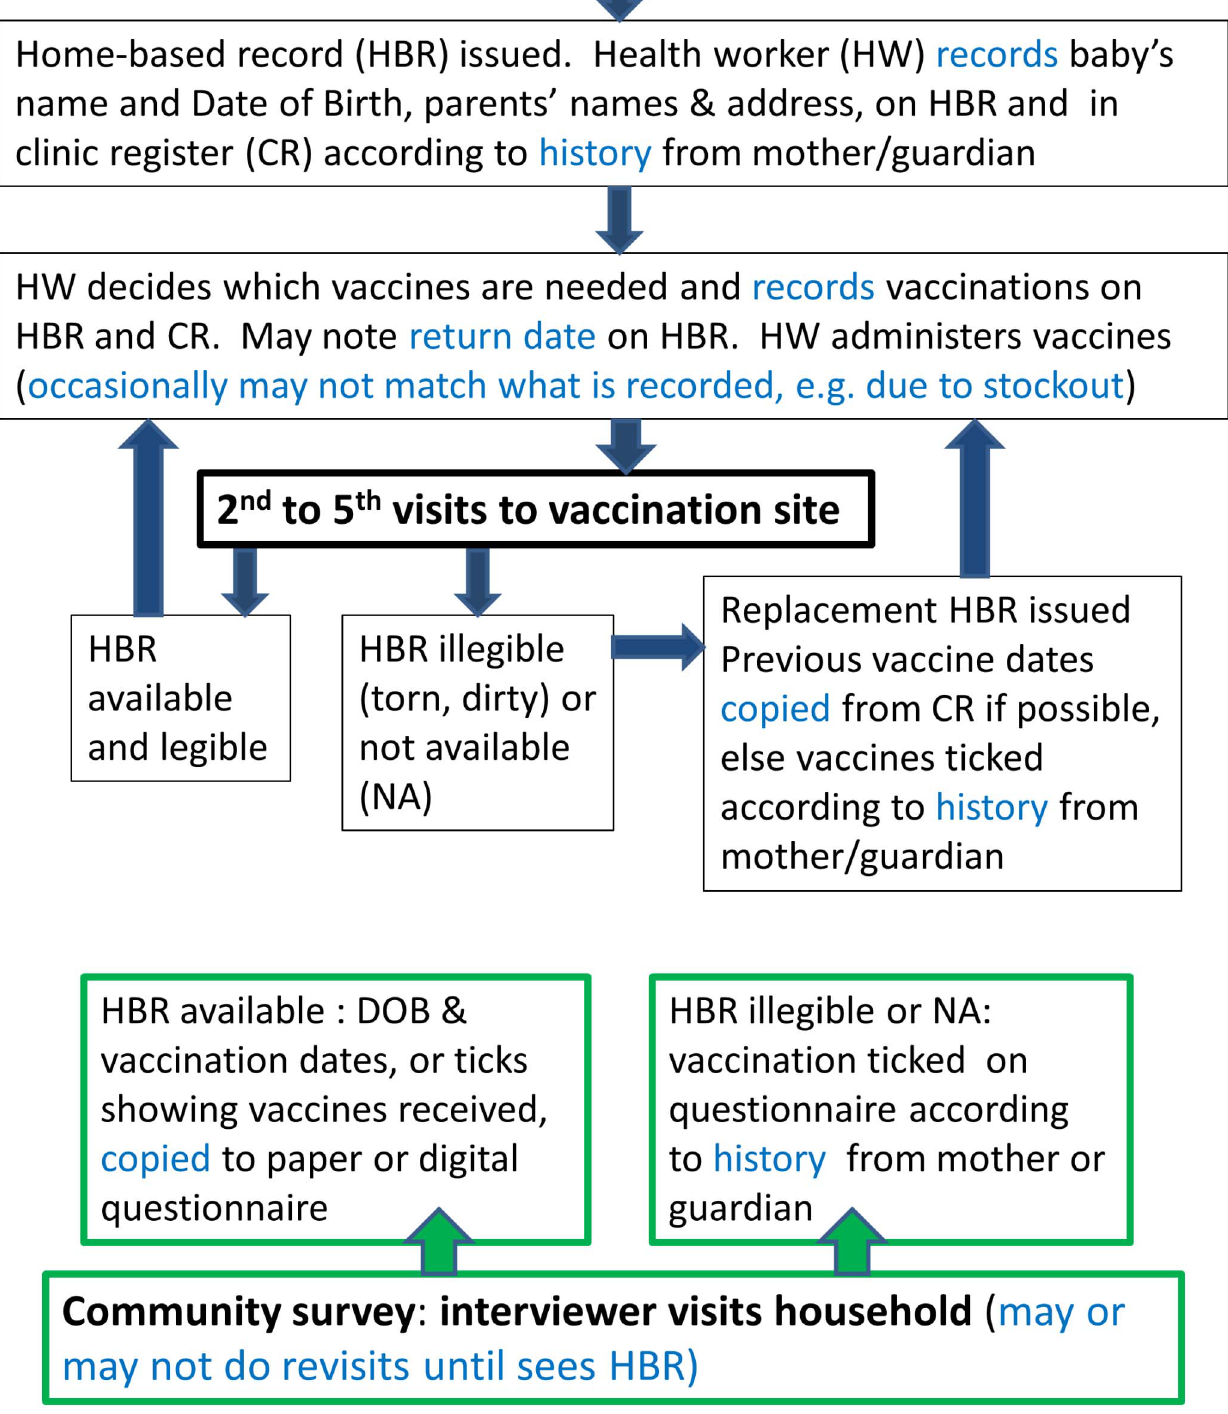
Figure 1. Schematic of recording of vaccination data at the time of vaccination and during community surveys. Recording at the time of vaccination (primary recording) is indicated in black boxes; recording during surveys is indicated in green boxes. Main potential sources of information error and bias are highlighted in blue. DOB, date of birth.